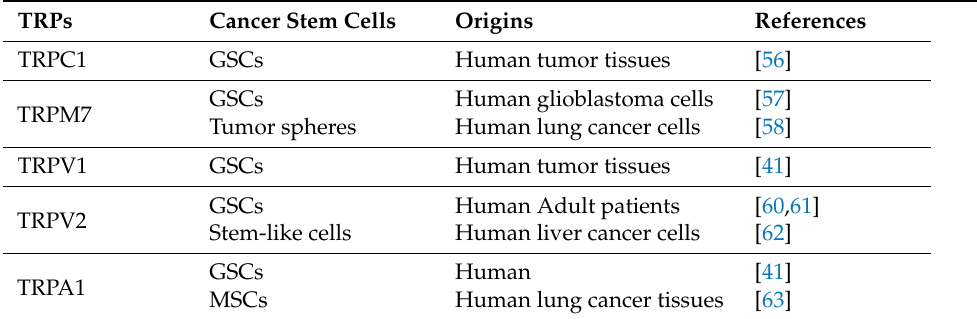
Table 2. TRPs expressed in cancer stem